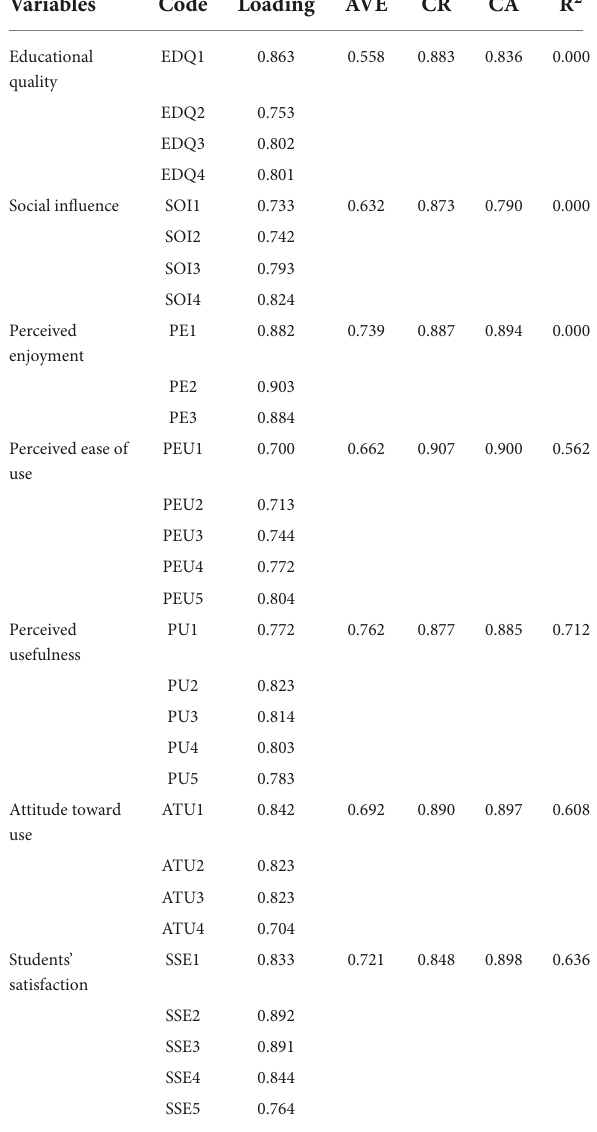
TABLE 2 Measurement model, item loadings, construct reliability, and convergent